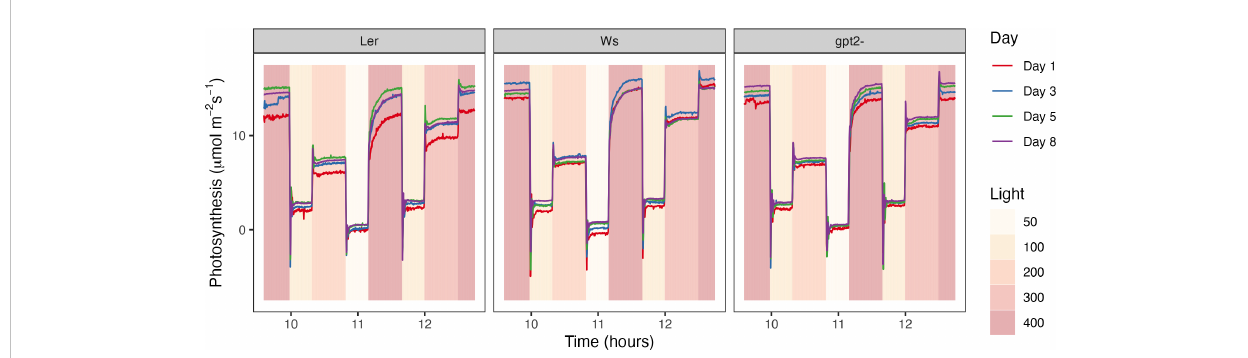
FIGURE 7 Measured photosynthesis rate in the days following a change in the light pattern. Measurements were made every 15 seconds throughout the light motif at days 1, 3, 5 and 8 post